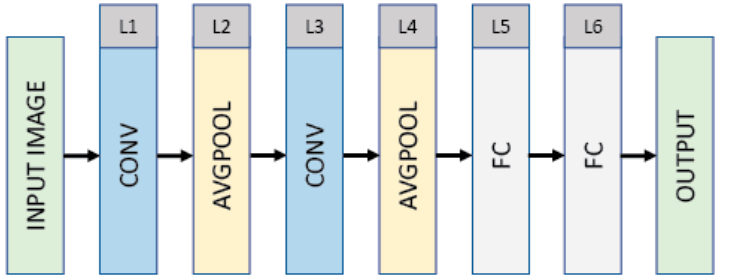
Figure 2. Architecture of the convolutional neural network (CNN) LeNet, consisting of six layers, excluding the input and output layers.